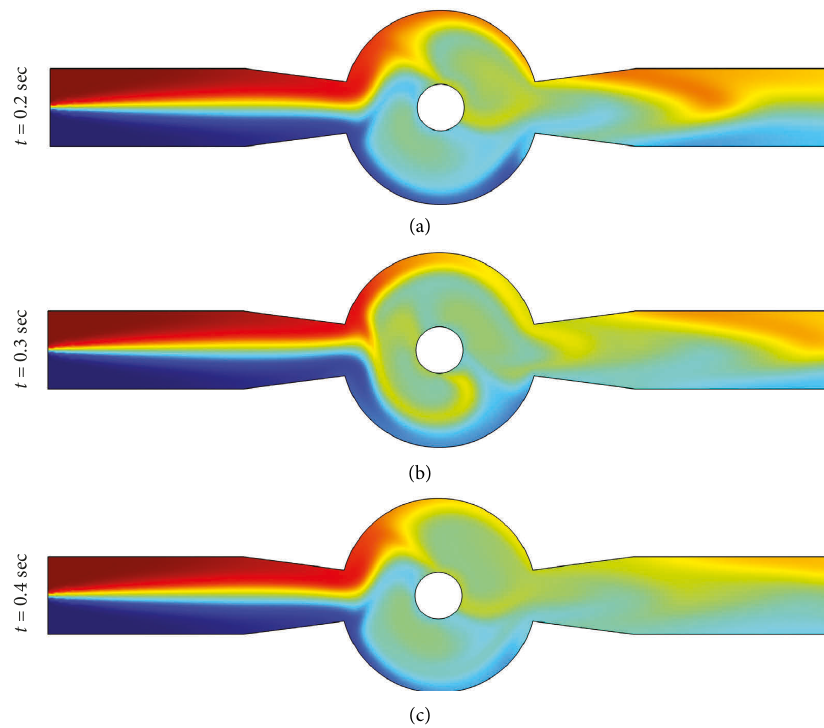
Figure 7: Concentration contour for the circular geometry at three times ( f � 5, u � 0.1, and φ � 0), (a) t � 0.2s; (b) t � 0.3s; (c) t � 0.4s.